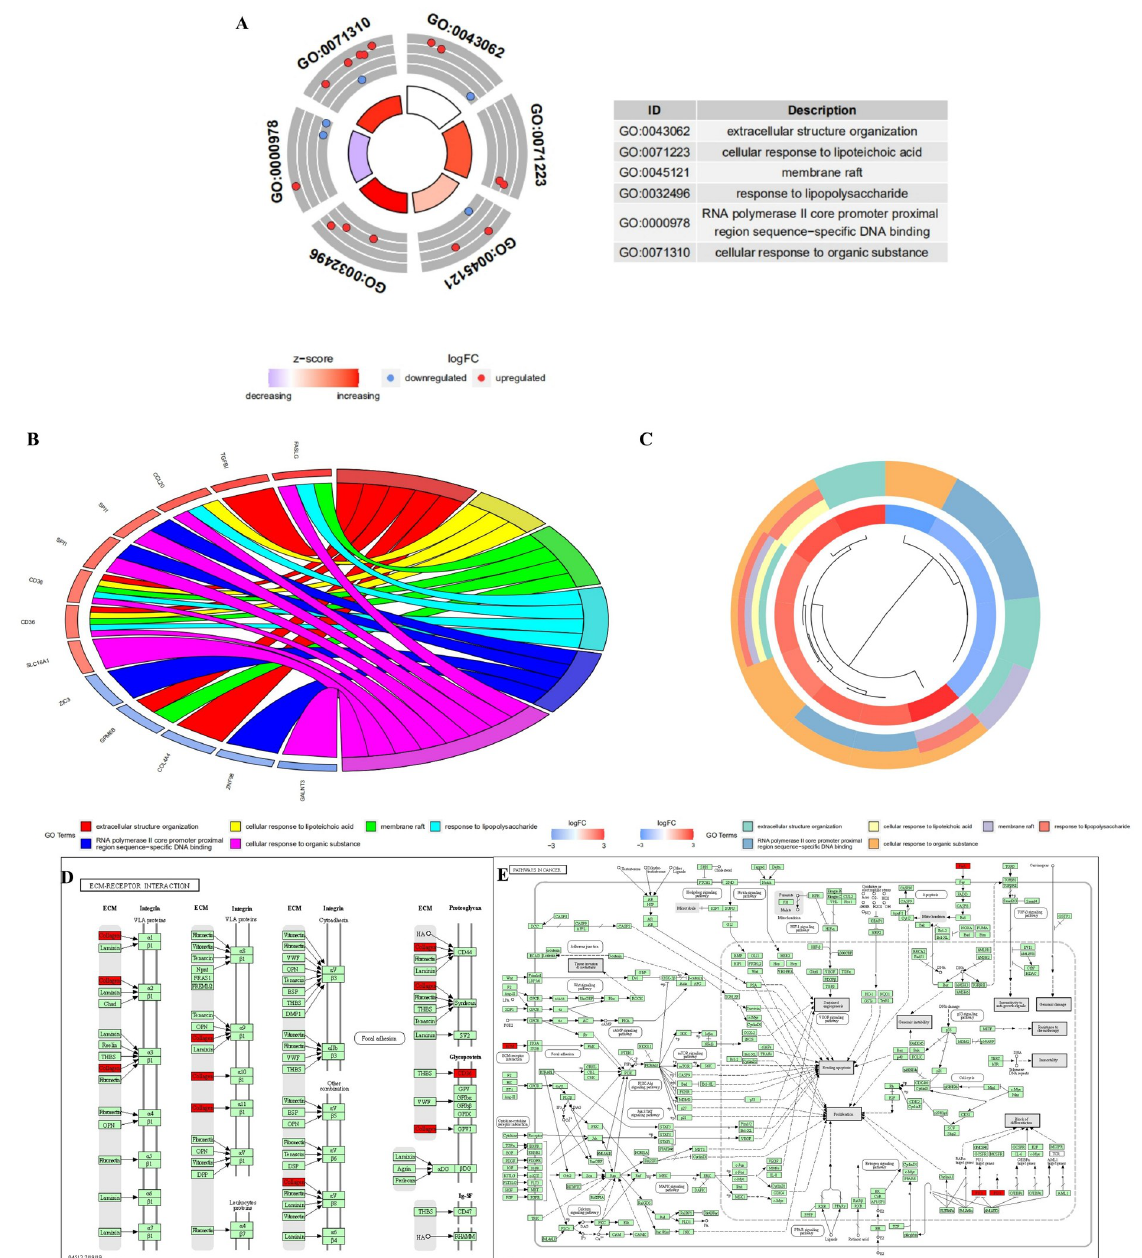
Fig 5. Functional enrichment and KEGG analysis of DEmRNAs related to lncRNA in KIRC. (a-c) The GOCircle, GOChord, and GOCluster diagram of DEmRNAs in KIRC. (d and e) The expression pattern of “ECM-receptor interaction” and “pathways in cancer”.